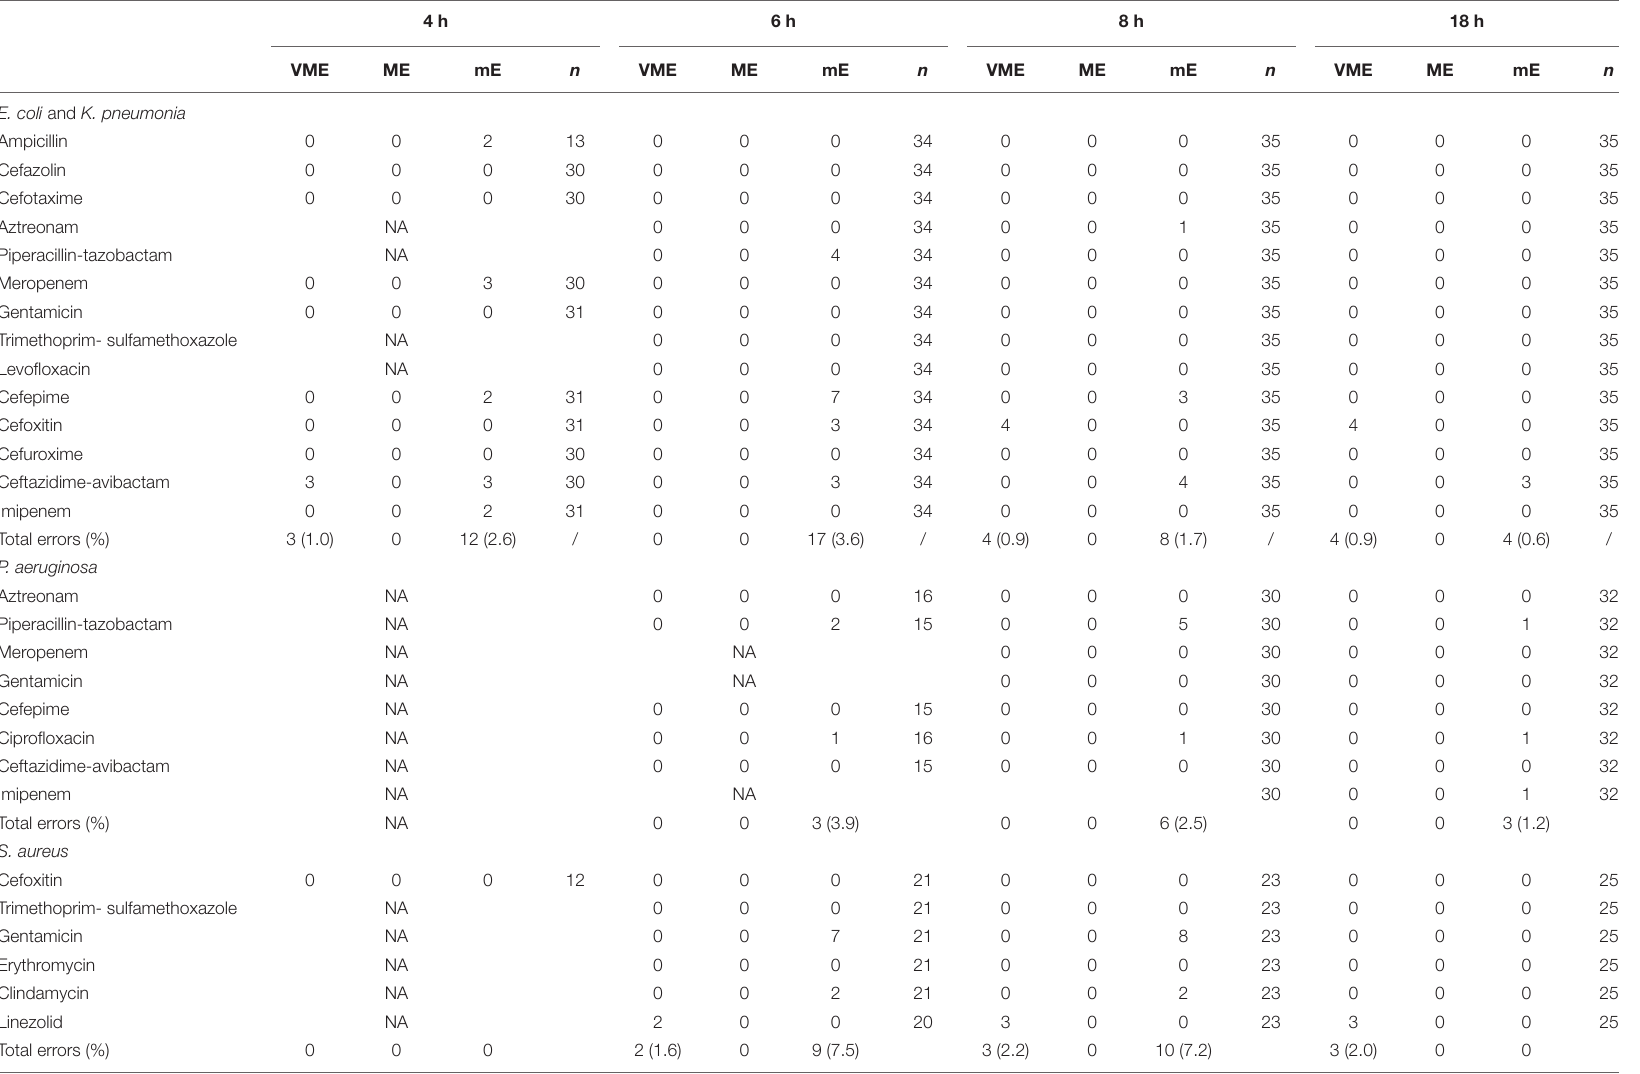
TABLE 3 | The categorical errors with rAST in clinical evaluating